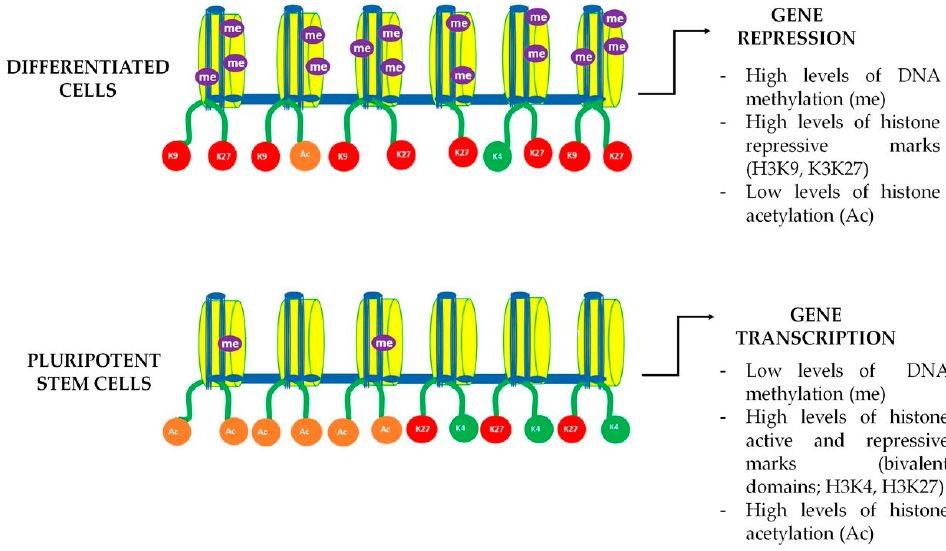
Figure 3. DNA bivalent domains dynamics in differentiated and pluripotent cells. Gene expression in stem cells is a dynamic process that is subject to chromatin remodeling. Chromatin dynamics and accessibility depend on the activation and repression marks known as H3K4 and H3K9 and H3K27 respectively. Pluripotent stem cells are known to have both active (green) and repressive (red) methylation marks in the same histone domain, enabling to trigger a fast gene transcription. During cell differentiation those bivalent marks are progressively lost leading to a more stable chromatin structure, only allowing the expression of a limited set of genes that are specifically necessary for mature cellular functions.